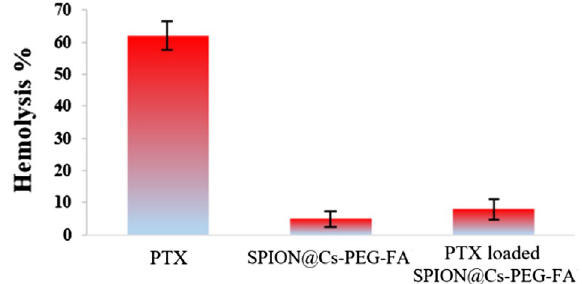
Figure 17. Quantitative hemolysis rates of PTX, SPION@Cs-PEG-FA, and SPION@Cs-PTX-PEG-FA. The error bars represent ± s.d. from n = 3.